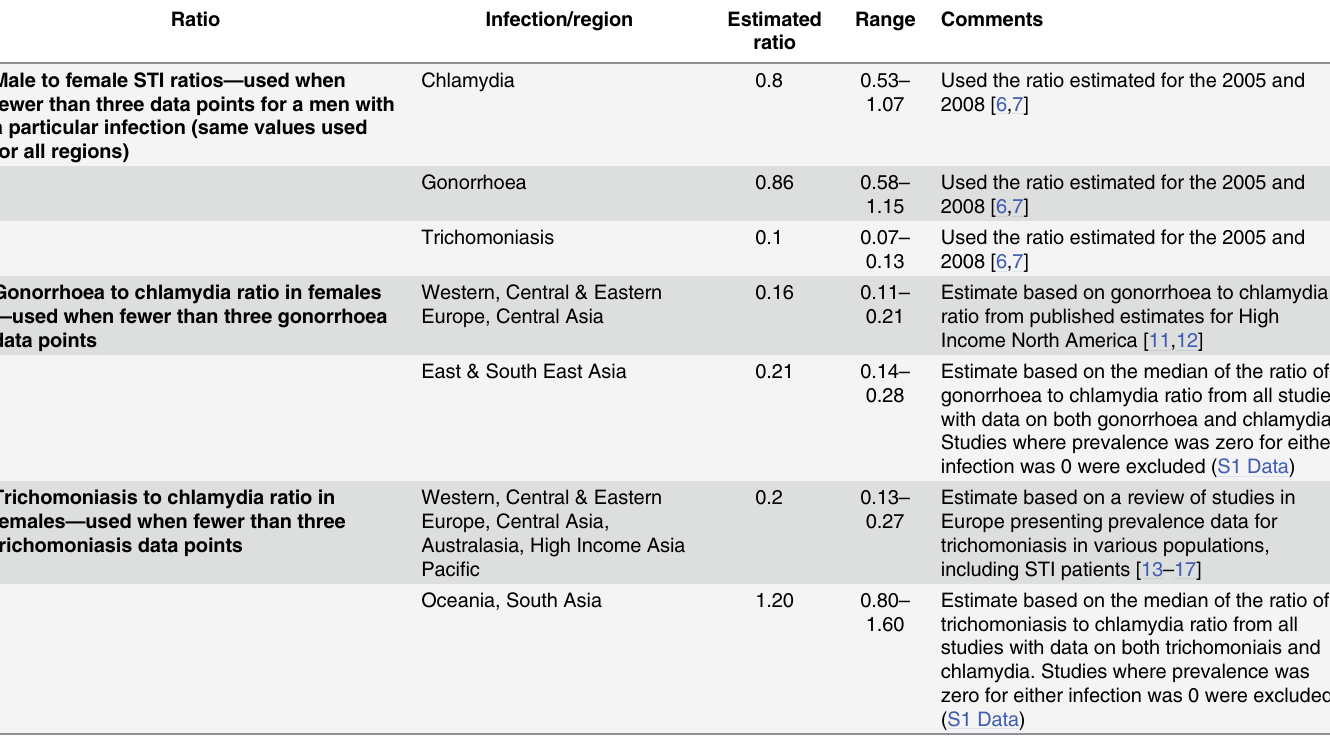
Table 2. Ratios used to estimate prevalence when data for chlamydia, gonorrhoea, or trichomoniasis were limited. Ratio